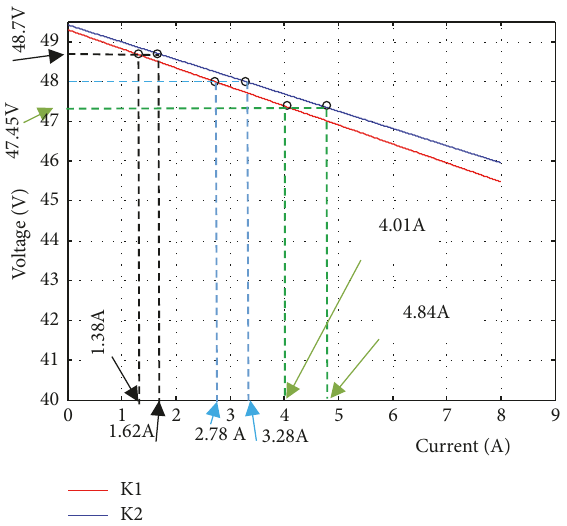
Figure 18: 20% mismatch in load regulation characteristic of the droop method for the two converters.